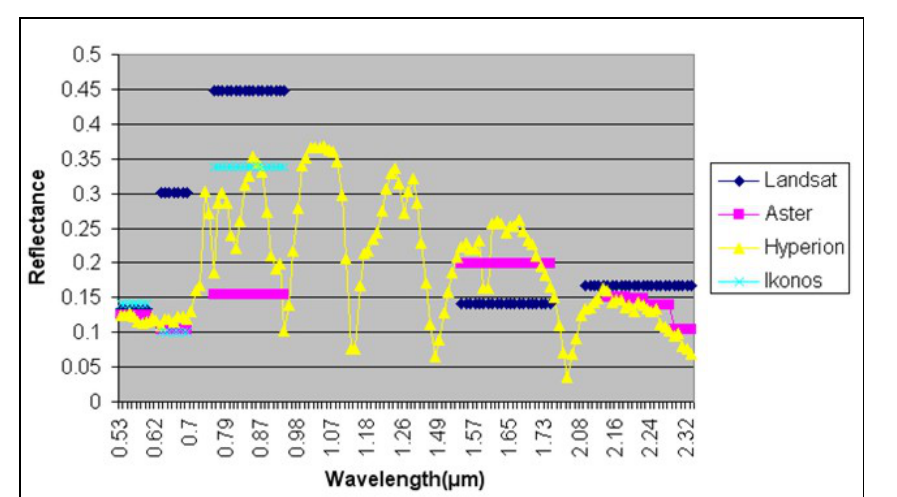
Figure 6. Comparison of spectral signatures of all the sensors from the Neolithic settlements collected from the plains of Thessaly.